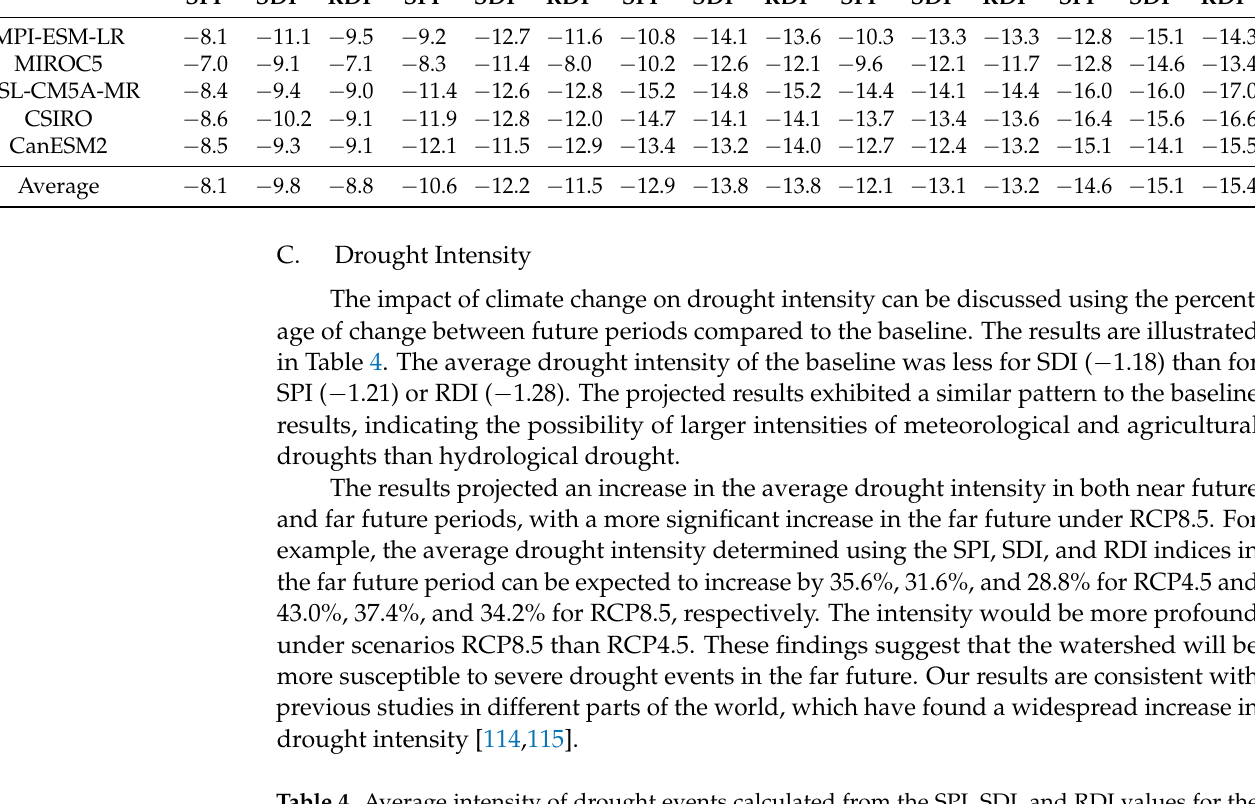
Table 4. Average intensity of drought events calculated from the SPI, SDI, and RDI values for the Bilate